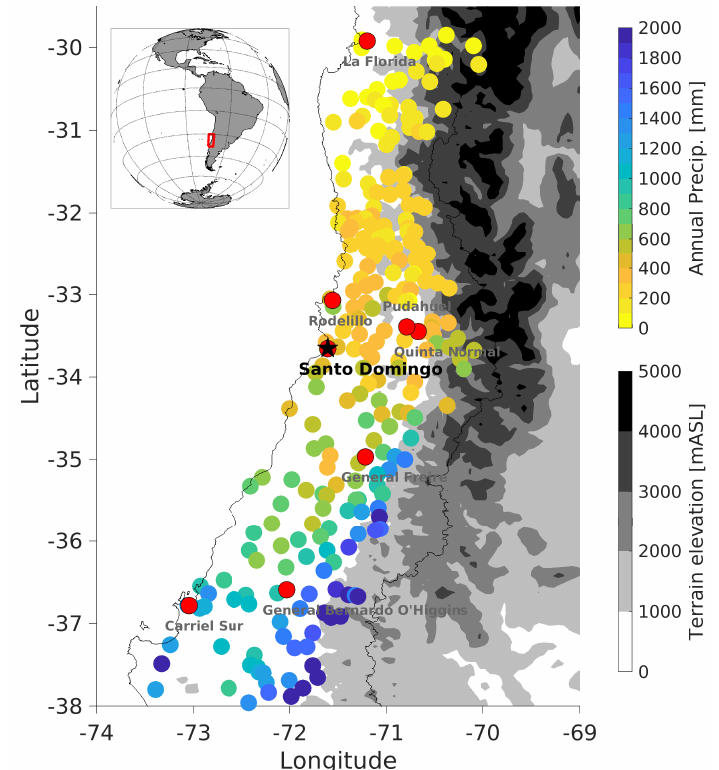
Figure 2. Station-based annual mean precipitation over Central Chile for the period 1981–2010, colored according to the scale to the right. Gray shading indicates topography levels from 0 to 5000 m ASL (every 1000 m). The black star shows the location of the Santo Domingo upper air station and red circles show selected stations with concurrent air temperature and precipitation records used to infer the freezing level during rainy